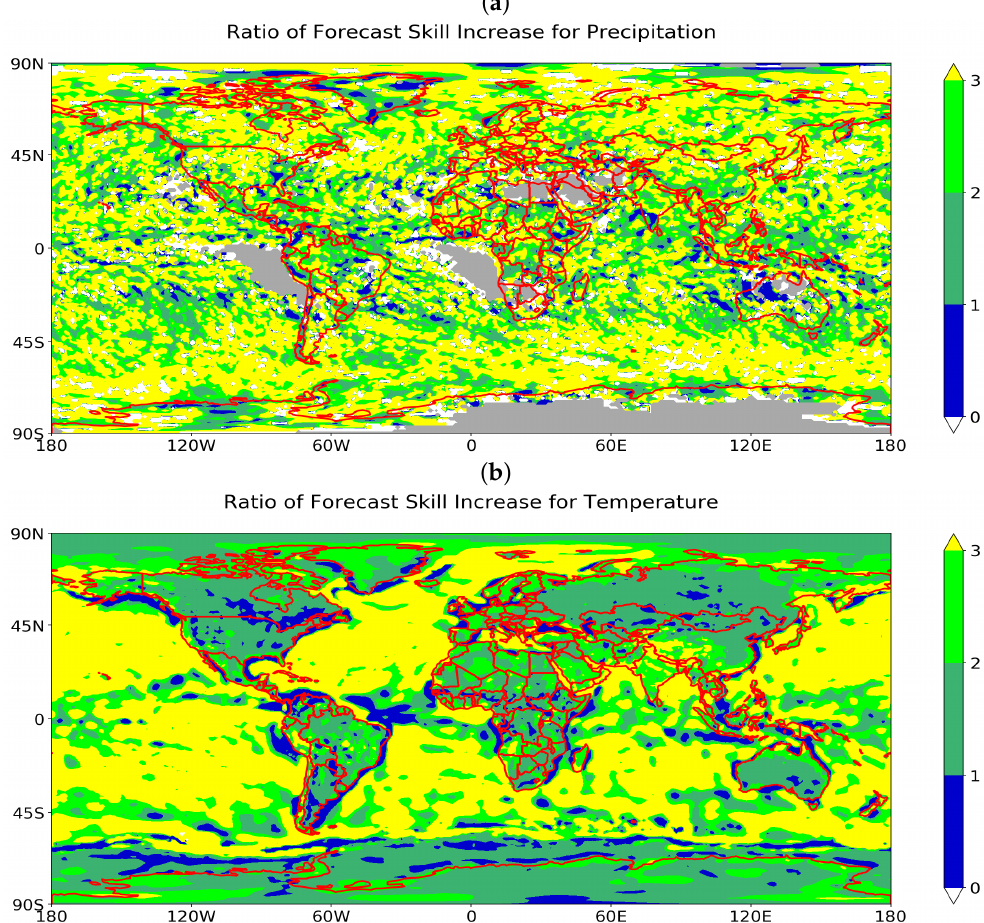
Figure 8. Global map of the ratio of forecast skill increase, defined as r = ∆ x ρ / ∆ t ρ , where ∆ x ρ is the change in forecast skill (pattern correlation) due to increased spatial averaging, and ∆ t ρ is the change in forecast skill (pattern correlation) for increased time averaging. ( a ) Precipitation. ( b ) Surface temperature. Detailed explanations for the white and grey colors can be found in the